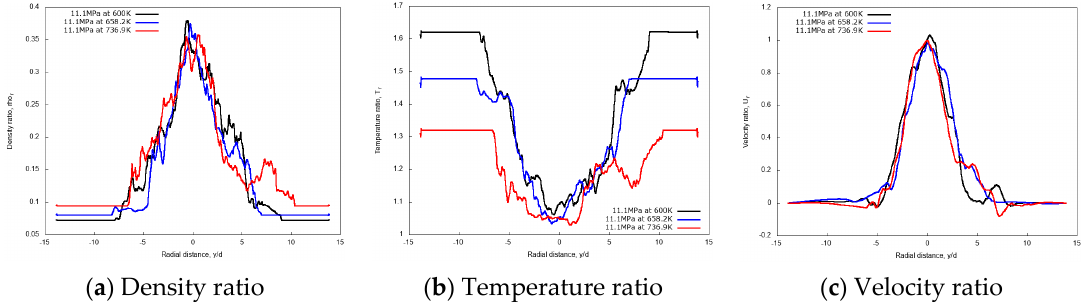
Figure 13. Radial profiles of non-dimensional density, temperature, and velocity ratios at fixed axial distance x / d = 20, for different n-dodecane injection temperatures: 600 K, 658.2 K, and 736.8 K. Simulations of n-dodecane injected at 200 m/s into a supercritical hot nitrogen, 972.9 K and 11.1 MPa.